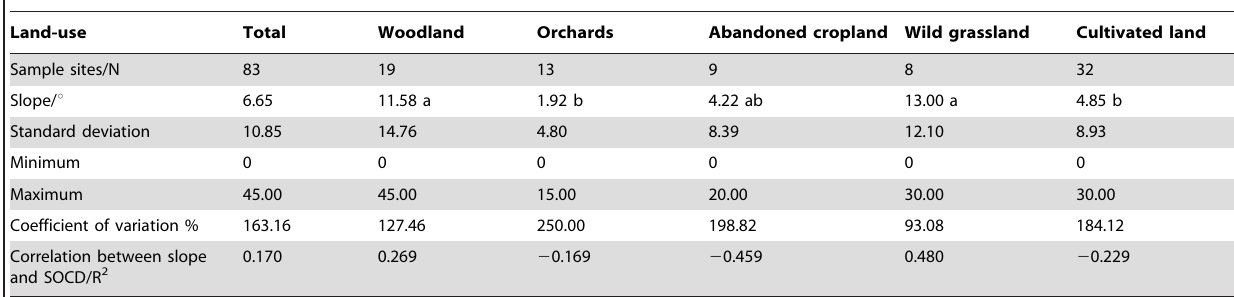
Table 4. Slope of different